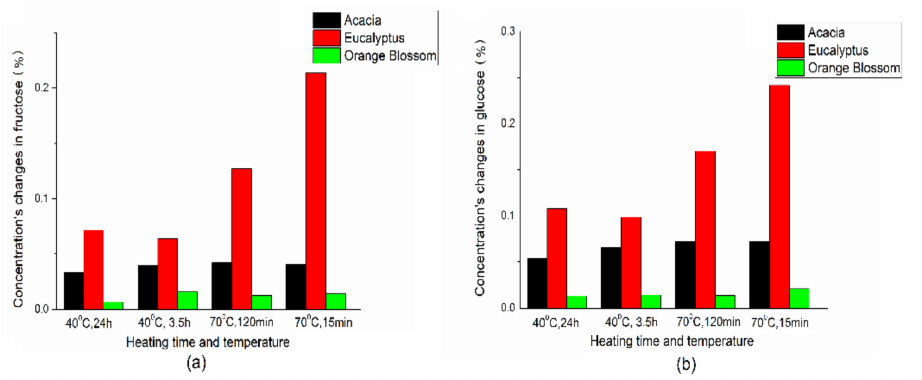
Figure 5. Relative changes in fructose ( a ) and glucose ( b ) concentrations, due to heating at different time and temperatures based on chromatography data (Table